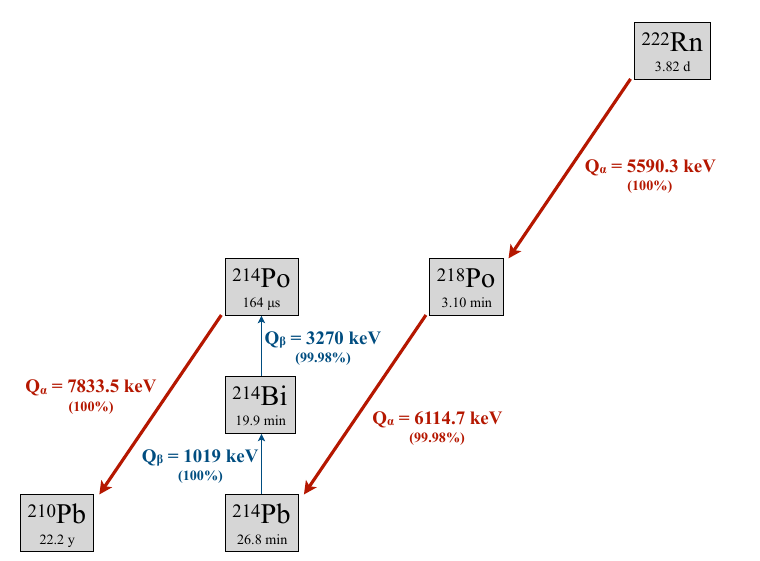
Figure 1 . Part of the 222 Rn decay scheme that is most relevant for this analysis. Quoted half-lives, Q-values and branching ratios are extracted from the ENSDF database